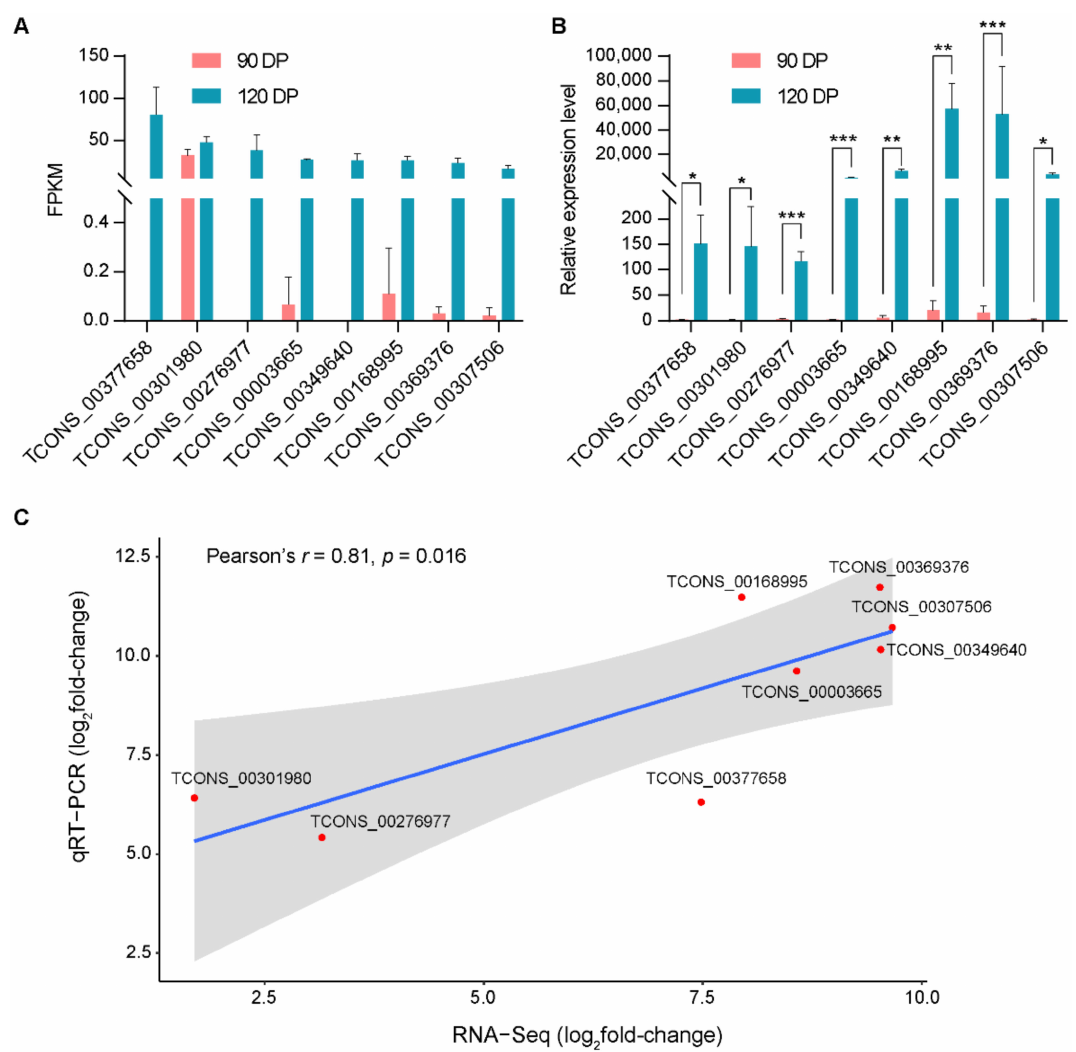
Figure 6. Validation of microarray results by qPCR analysis. ( A ) The results of RNA-seq of differentially expressed lincRNAs (DELs) of 120 DP vs. 90 DP. ( B ) The results of qRT-PCR of DELs of 120 DP vs. 90 DP. The goat beta-actin (ACTB) gene was used as reference gene. Data are shown as means ± SE ( n =3). *: p < 0.05, **: p < 0.01, and ***: p < 0.001. ( C ) Correlation of RNA-Seq and qRT-PCR. Comparison of changes in lincRNA expression (represented as log2) derived from RNA-Seq and qRT-PCR revealed a significant correlation (Pearson’s r = 0.81 and p = 0.016 at the α level of